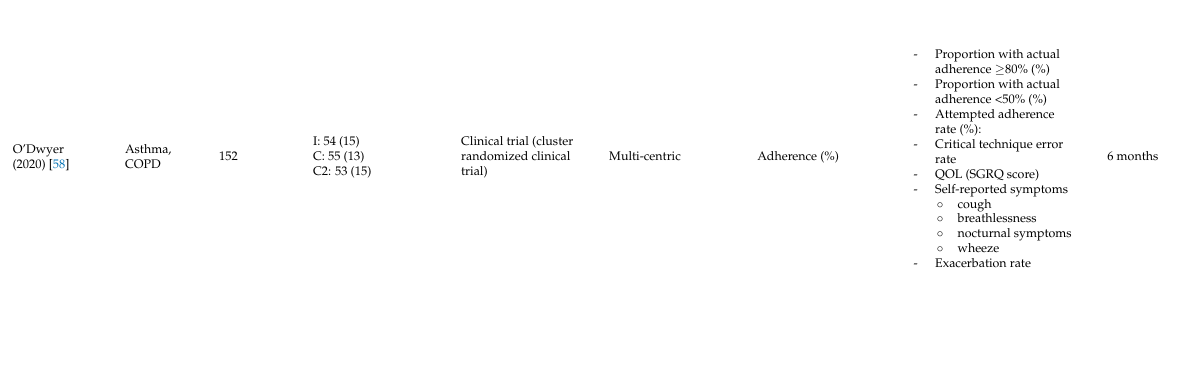
Self-managementfor patients. Accessto informationand relatedinterventions byHCP.